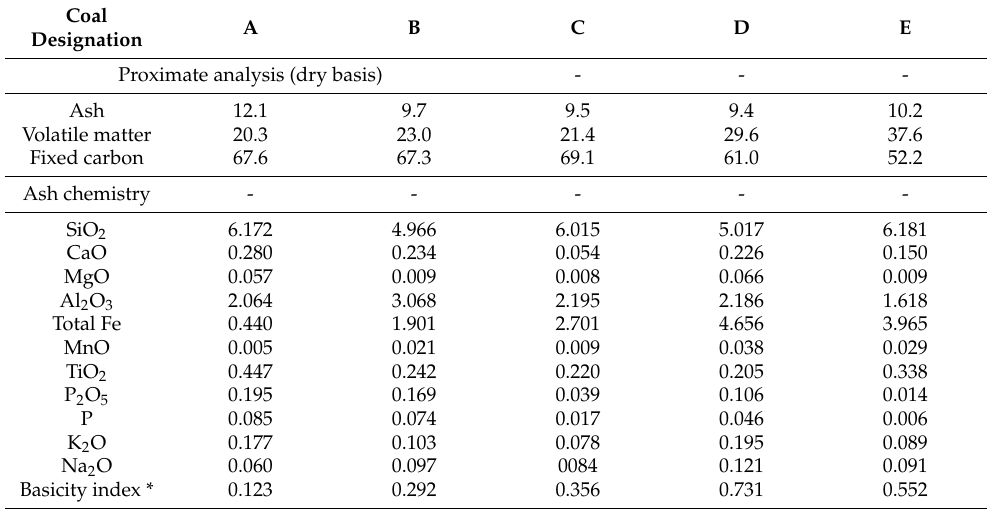
Table 1. Proximate analysis and coal ash analysis of the parent coals (% by